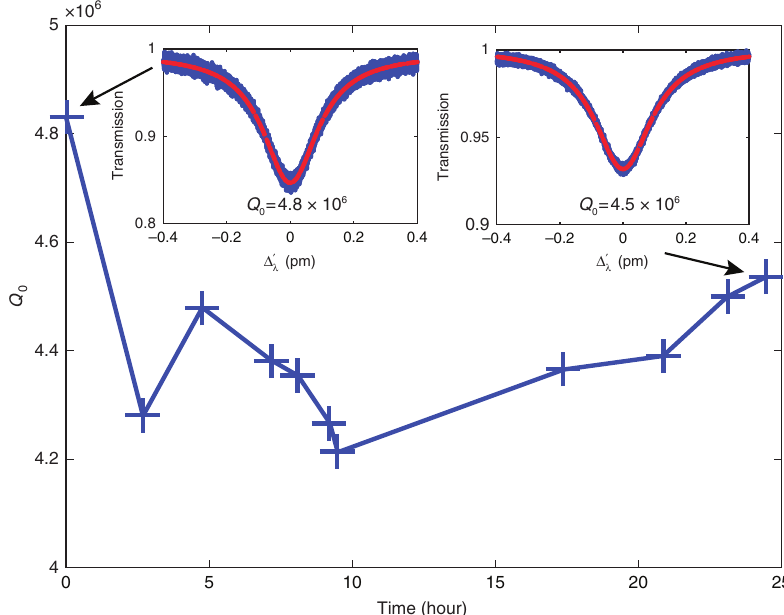
Figure 5 | Cavity Q degradation test. Main plot: the intrinsic quality factor ( Q 0 ) versus time; left inset: Q 0 ¼ 4.8 (cid:2) 10 6 when the silica microsphere was just immersed in DPBS buffer and right inset: Q 0 ¼ 4.5 (cid:2) 10 6 after 25h. The blue trace in each inset is the normalized transmission spectrum averaged over 100 traces and the red curve is the least square fit of the transmission curve to a Lorentzian